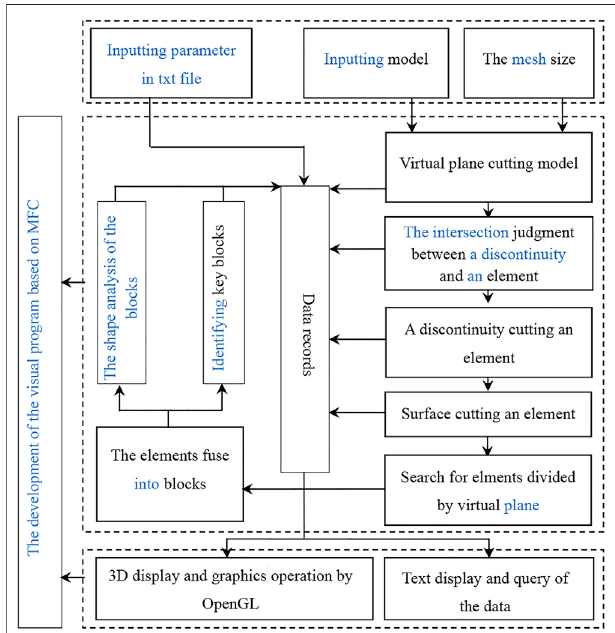
FIGURE 10 | The development process of the visual